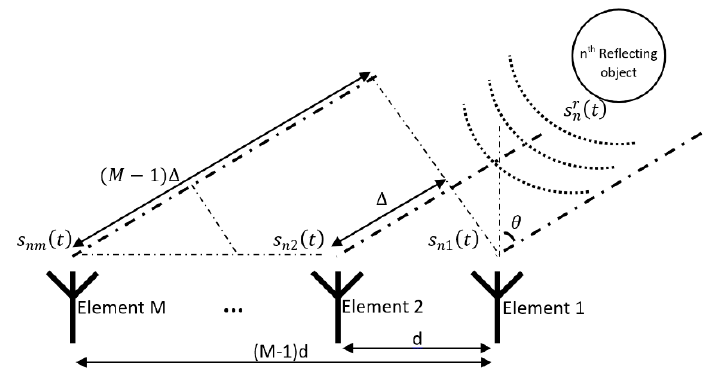
Figure 2. Uniform linear array (ULA) configuration.